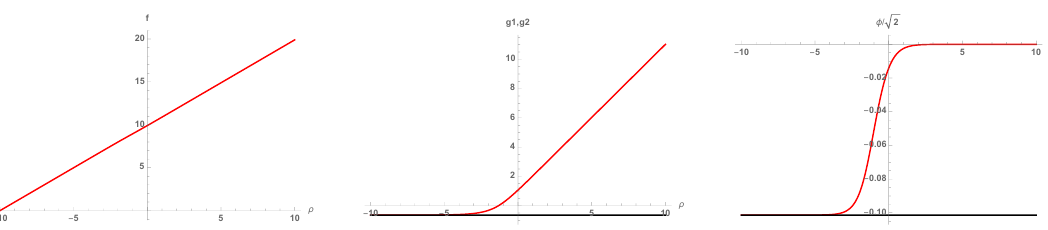
p 2 and g = 3 m . The black straight lines are